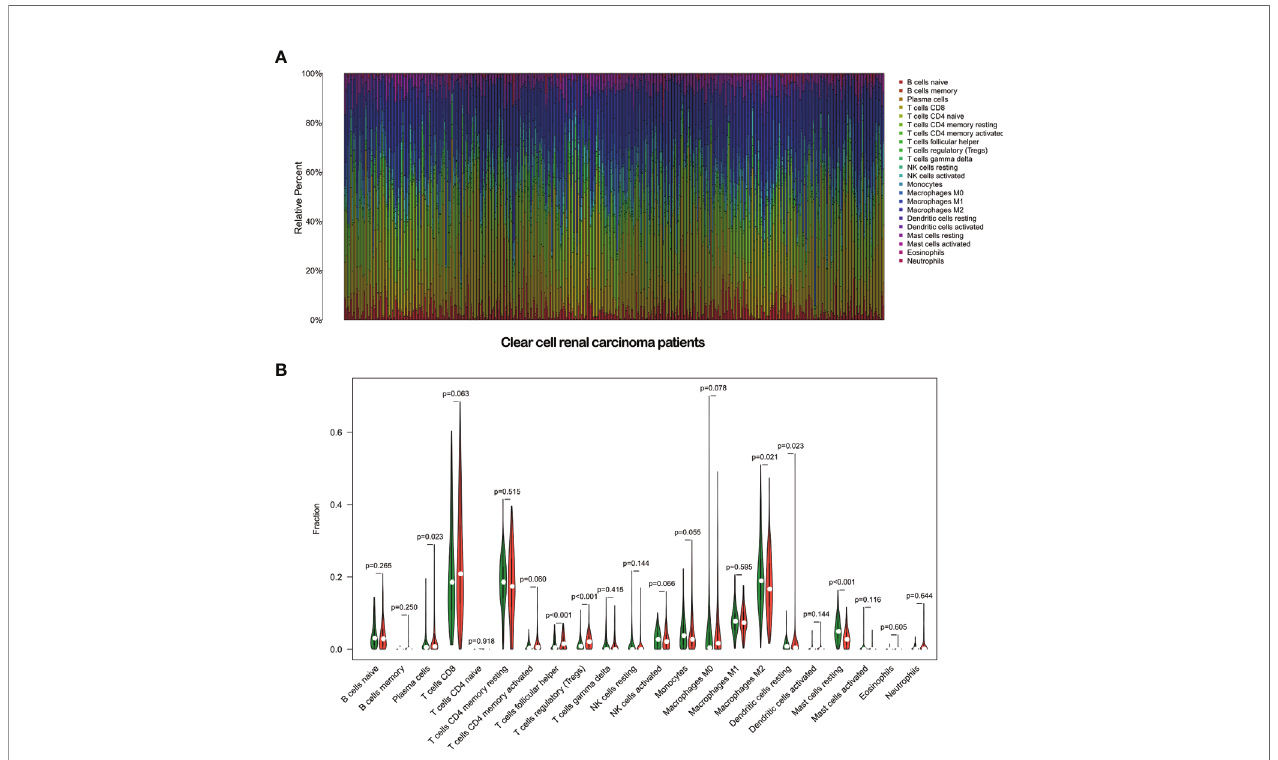
FIGURE 9 | Immune landscape of the patients with clear cell renal carcinoma (A) . Relationships between the risk score and the immune cell in fi ltration in clear cell renal carcinoma (B)